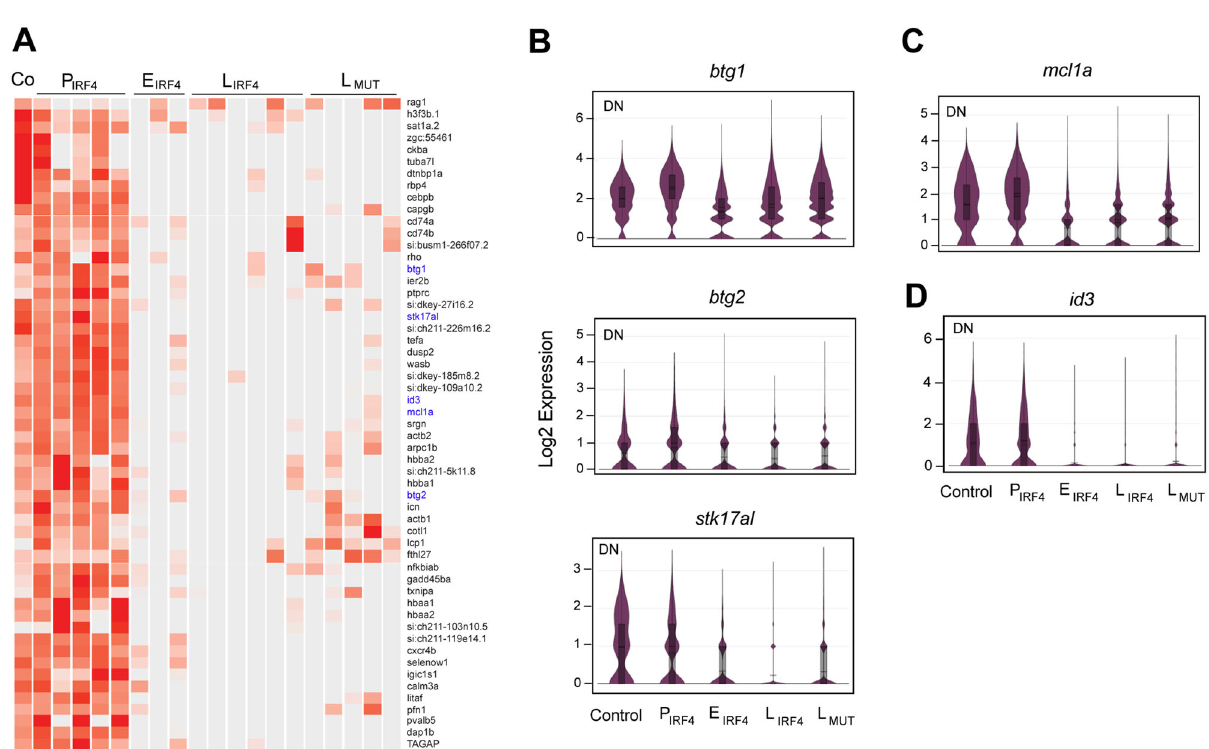
Fig. 6 Downregulation of p53 targets and id3 . A Heatmap showing the signi fi cantly downregulated genes from one-to-one differential gene analysis of scRNA-seq data between DN populations of different tumor stages. B – D Violin plots showing the expression of btg1, btg2 and stk17al ( B ) , mcl1a ( C ), id3 ( D ) in DN cell populations across tumor stages analyzed by scRNA-seq (total cell number after merging of biologically independent samples: Control n = 557 cells; P IRF4 n = 2,222 cells; E IRF4 n = 3,365; L IRF4 n = 15,280 cells; L MT n = 28,205 cells). See Fig. 5C legend for the details of violin plots. Source data are provided as a Source Data fi